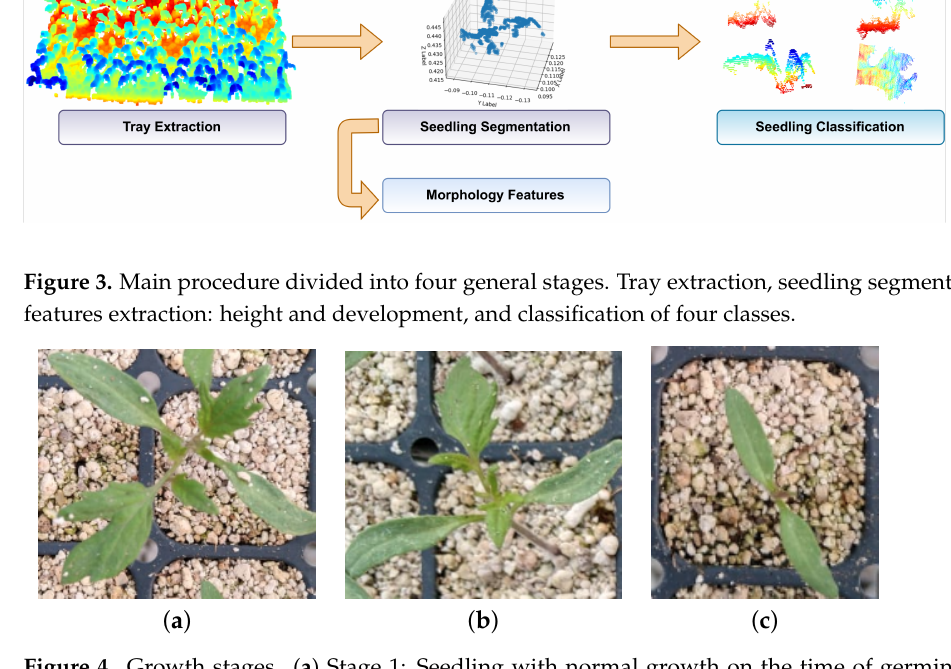
Figure 4. Growth stages. ( a ) Stage 1: Seedling with normal growth on the time of germination. ( b ) Stage 2: Seedling whose germination occurred days after the first stage with smaller size. ( c ) Stage 3: Seedling that germinated after the second stage, and it will grow outside of the estimated harvest time.